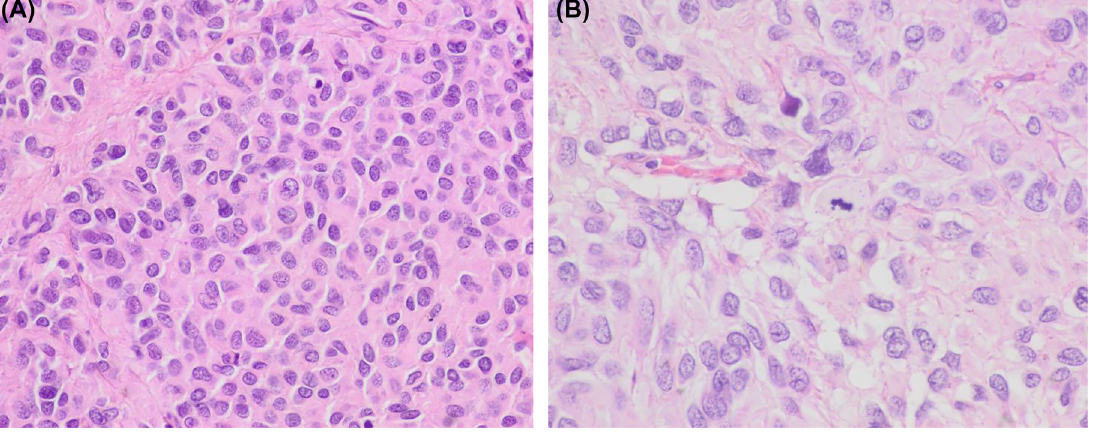
Figure 2: Histologic images of the abdominal tumor. (A, B) Histology of the ileum tumor showing predominant epithelioid cell morphology. A mitotic figure is evident in image B (hematoxylin and eosin, × 400 and × 600,